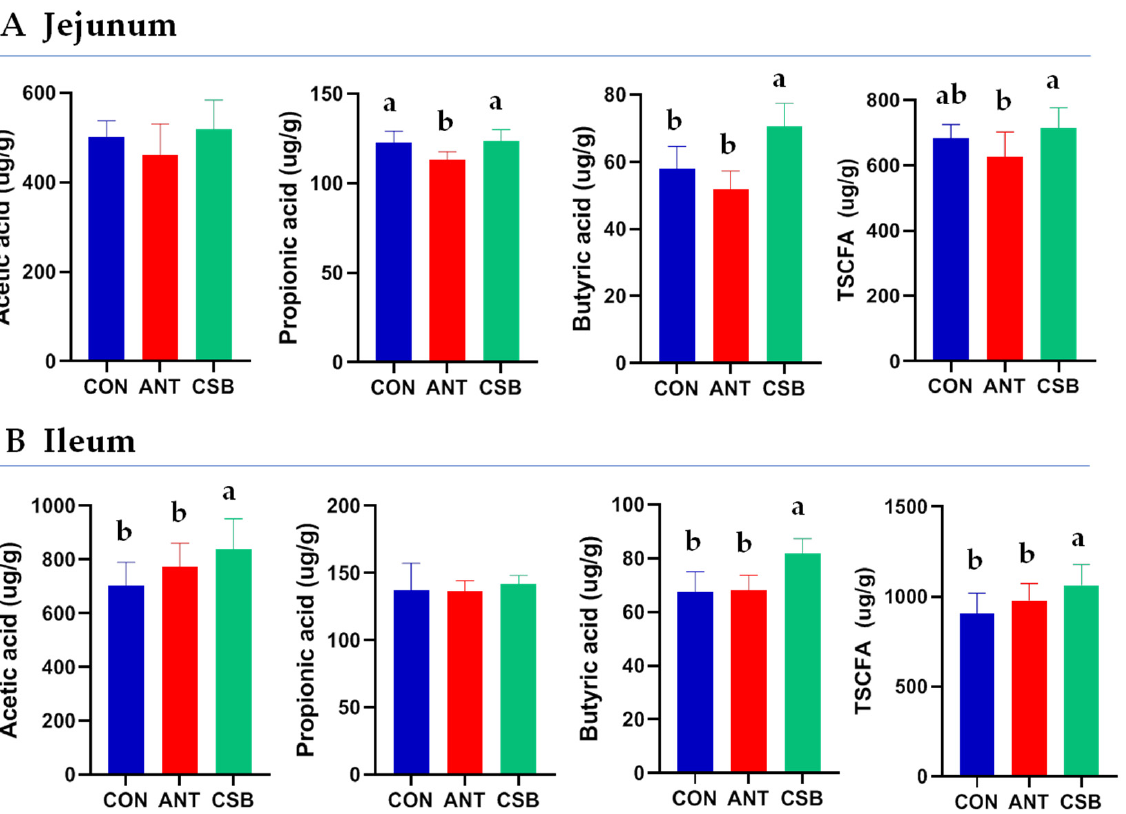
Figure 4. Effects of CSB on SCFA concentrations of the small intestinal chyme in broilers at 21 d of age. Acetic acid, propionic acid, butyric acid and total SCFA (TSCFA) concentrations were expressed as microgram per gram of chyme ( µ g/g). a,b: mean values were significant difference in the bars labeled with different letters ( p < 0.05).